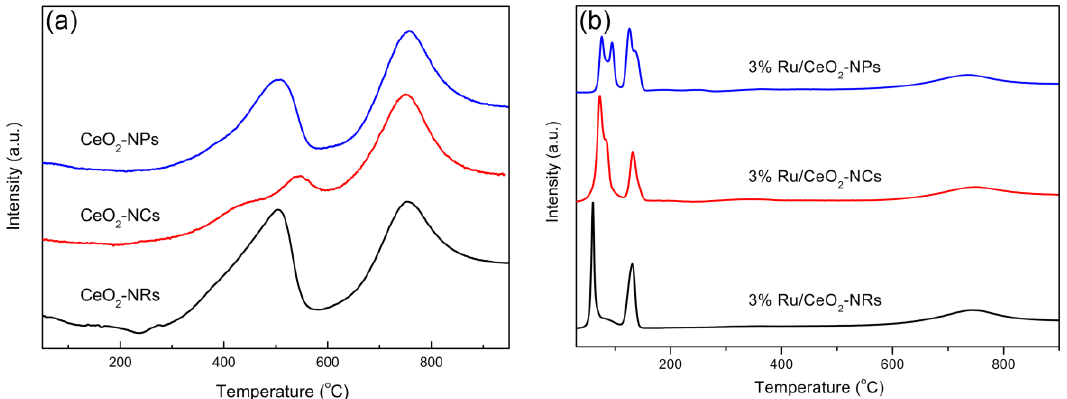
Figure 3. H 2 -temperature programmed reduction (H 2 -TPR) curves of ( a ) CeO 2 samples ( b ) Ru/CeO 2